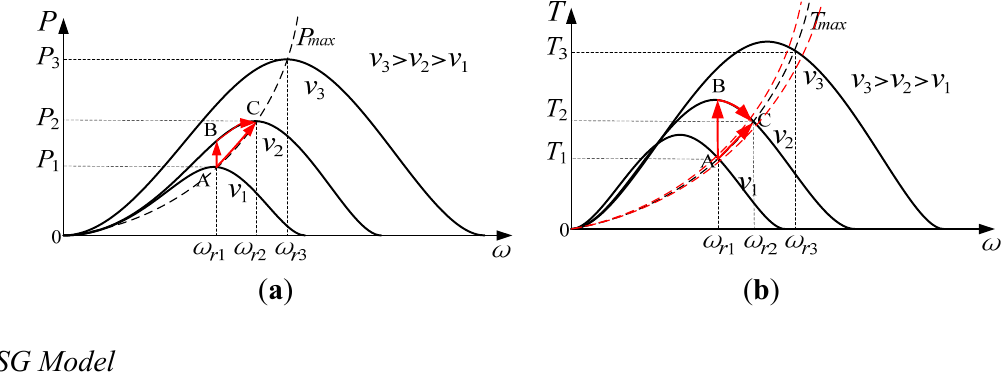
Figure 3. Wind turbine characteristics ( a ) Power versus rotor speed; ( b ) Torque versus rotor